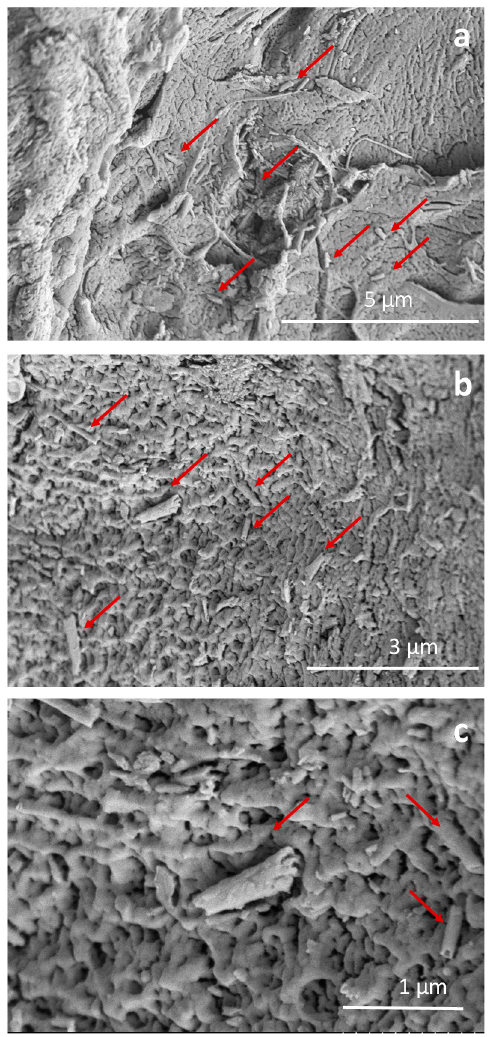
Figure 2. Micrographs of G-HNT granules at different magnifications, highlighting the dispersion of halloysite nanotubes–strontium ranelate (HNT–SrR) (red arrows) ( a and b ) and the nanotube morphology ( c ).